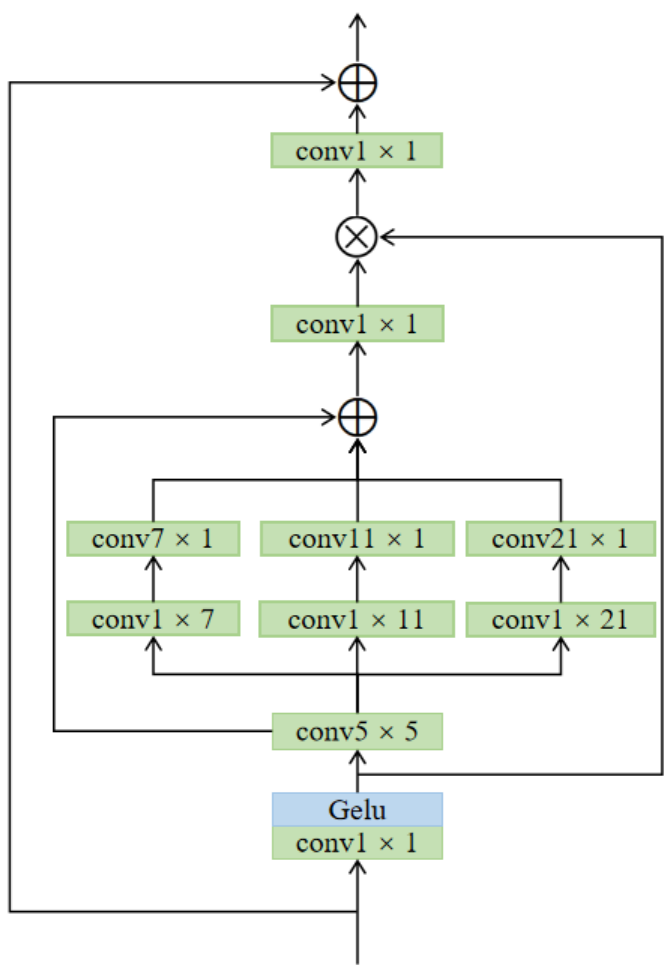
Figure 4. Convolutional attention